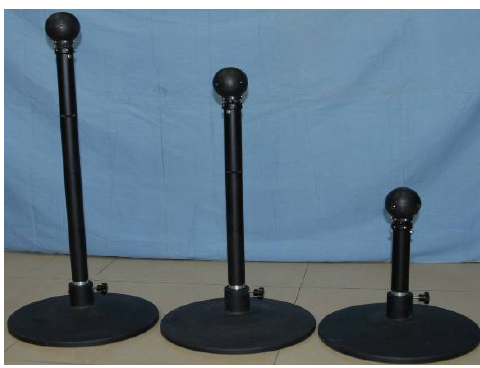
Figure 2. Sketch map of system constituent.